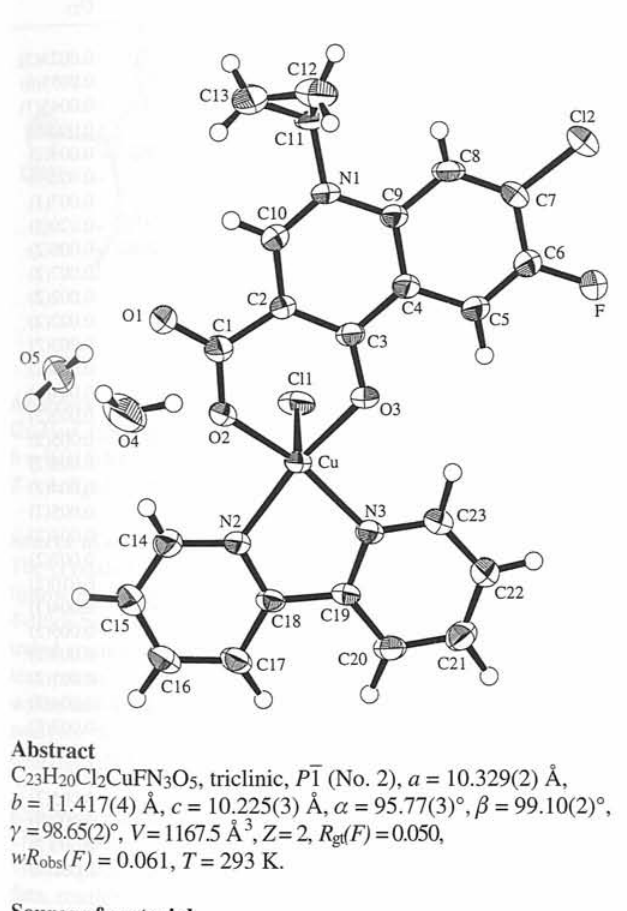
Table 1. Data collection and handling.